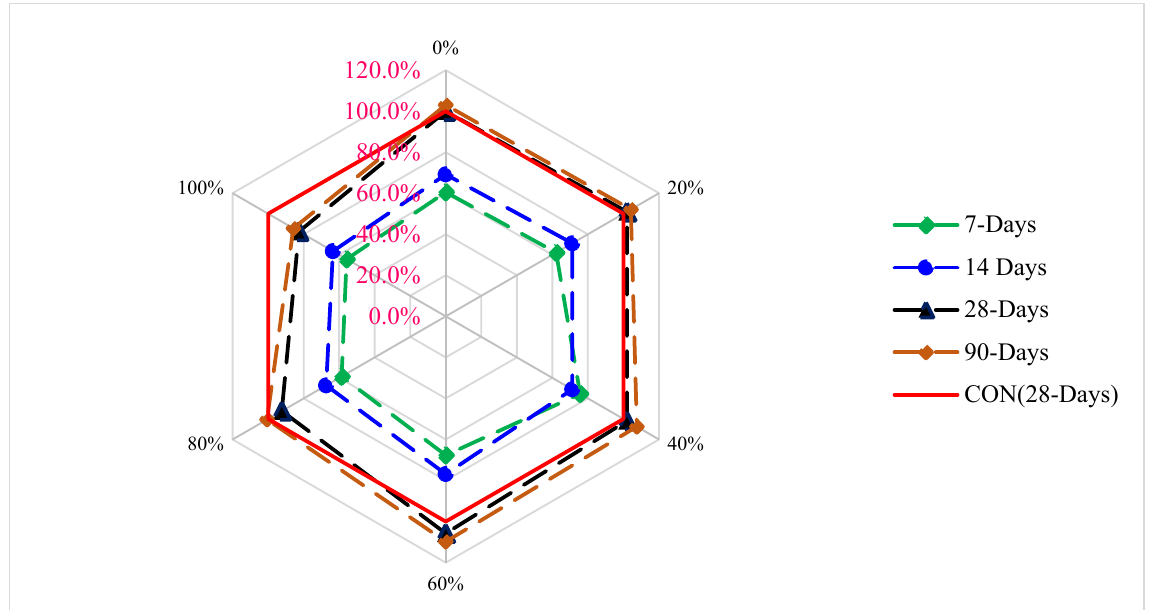
Figure 10. Relative split tensile strength of concrete: data source [45].